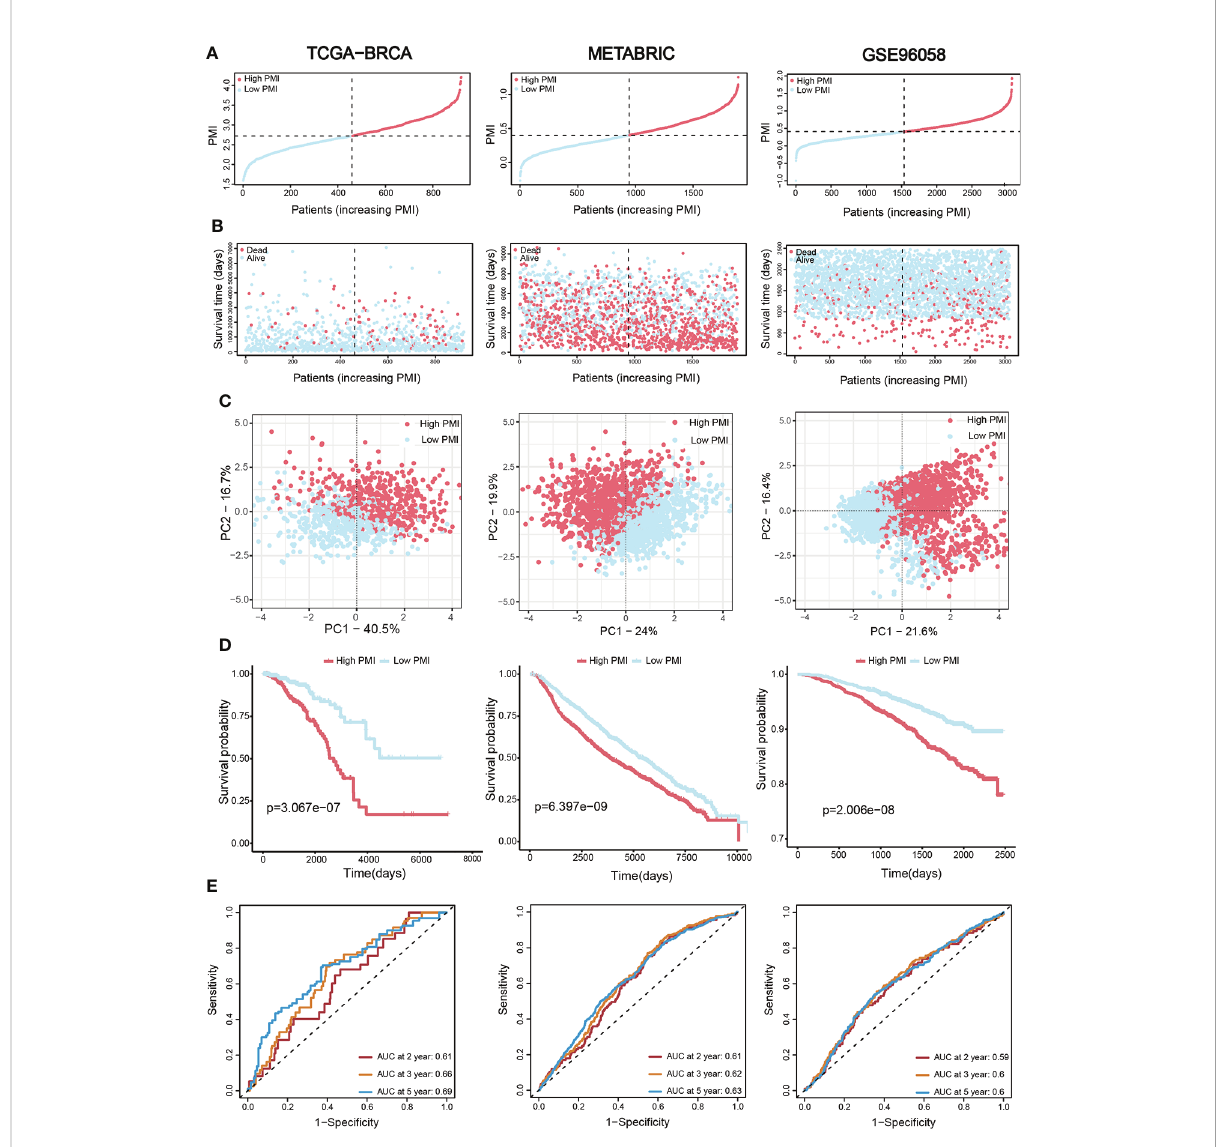
FIGURE 5 Assessment and veri fi cation of the ef fi ciency of the PMI signature. (A) The increasing PMI score in TCGA-BRCA, METABRIC, and GSE96058. (B) Variations in the deaths of BC patients accompanied by PMI increasing. (C) The PCA analyses of high- and low-PMI clusters. (D) KM analyses of overall survival probabilities between the high- and low-PMI subgroups. (E) The ROC curves of the PMI-only model in predicting 2-, 3-, and 5-year OS of BC